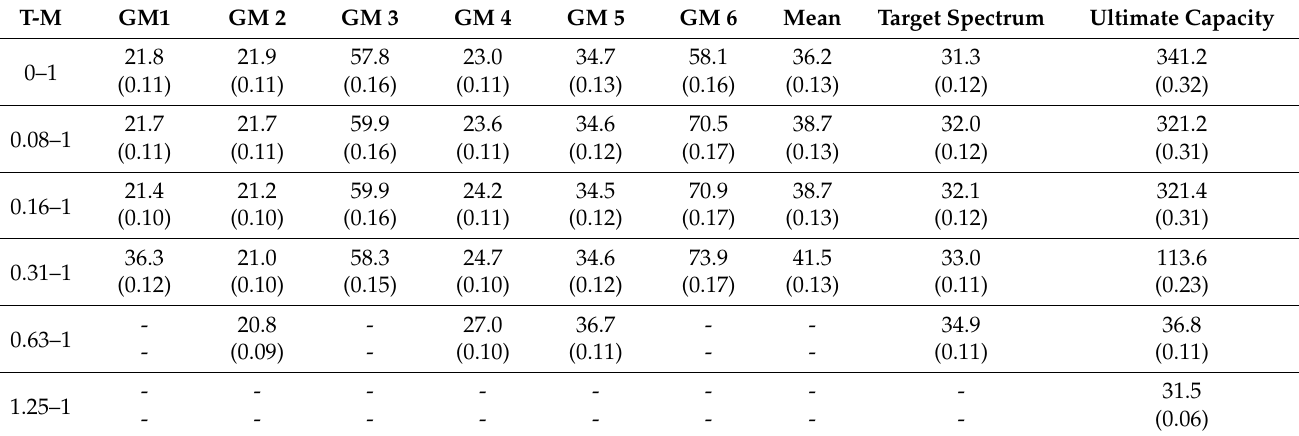
Table 3. The displacement demand (in mm) and acceleration demand (in parenthesis, given in ‘g’ units) are presented for the equivalent single-degree-of-freedom system, representing the RC U-shaped wall building structure, subjected to different combinations of torque and bending moment (T-M). The peak capacity for the building is presented (final column), which can be compared to the ground motion demands, their mean, or the demand calculated from the code spectrum (AS